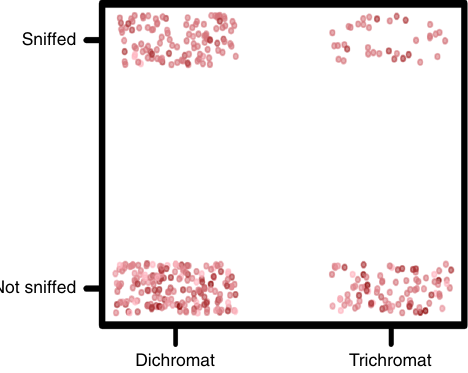
Fig. 3 Snif fi ng behaviour and primate colour vision type plotted with red – green contrast between unripe and ripe fruits. Each dot represents an individual monkey – plant species combination. Data points were binomially classi fi ed as to whether that monkey was ever observed snif fi ng the fruits of that plant species and are vertically and horizontally jittered in each quadrant. Darker red dots represent a larger red – green chromatic contrast between ripe and unripe fruits in the visual space of a trichromatic capuchin monkey. Dichromatic monkeys sniffed fruits signi fi cantly more often than trichromatic monkeys did, regardless of red – green contrast, glmm: p < 0.01. Source data are provided as a Source Data fi le